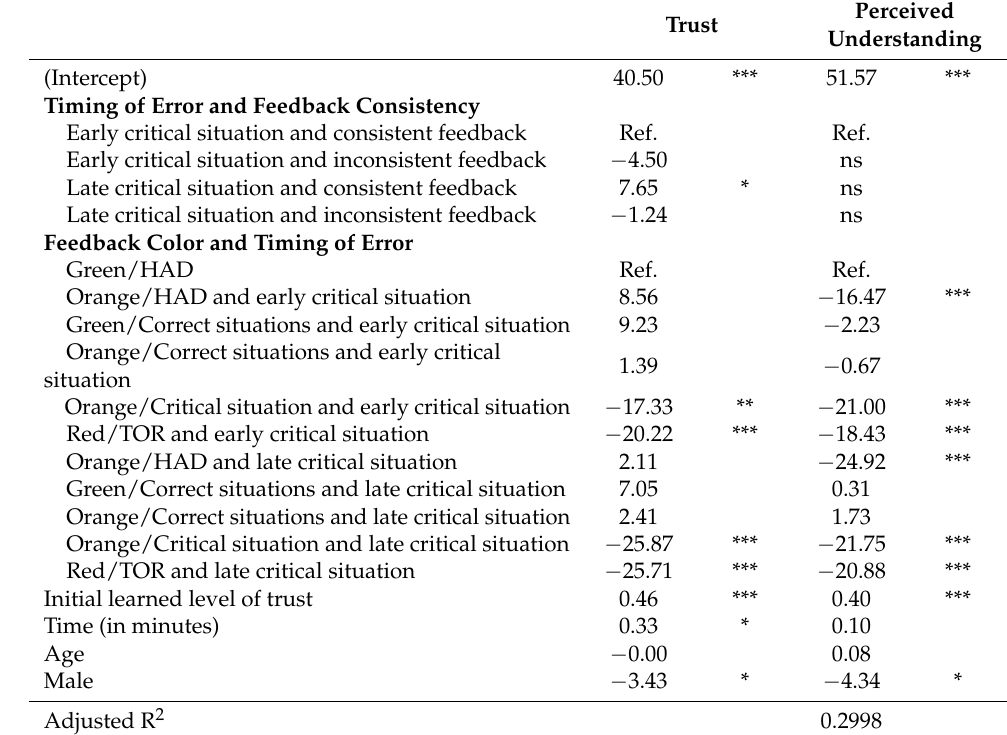
Table 4. Linear models of trust and perceived understanding. ***: p < 0.001; **: p < 0.01; *: p < 0.05; ns: not significant.